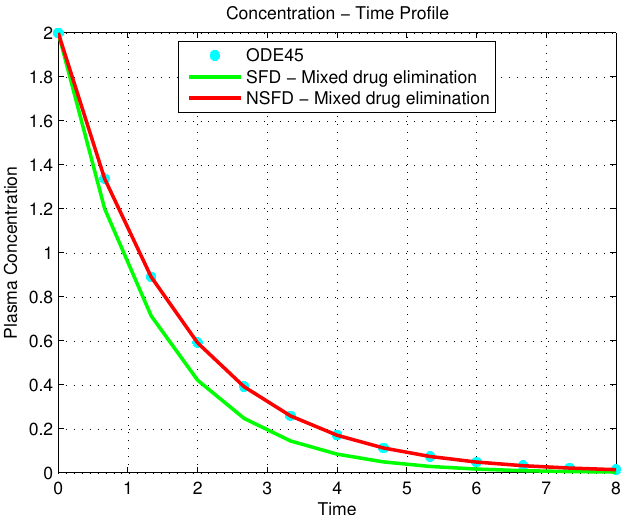
Figure 8. Trajectory representation of the one-compartment I.V. bolus injection model that follows mixed drug elimination. The SFD scheme (39) and NSFD scheme (41) plotted against ODE45 of (38).